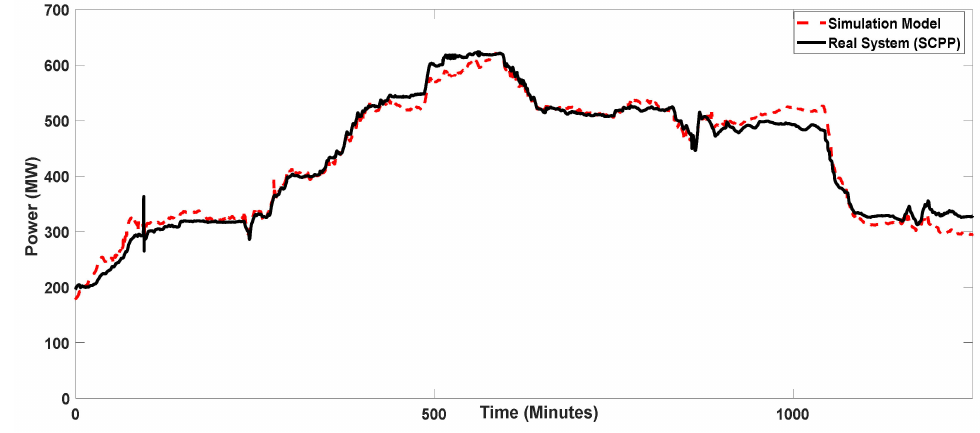
Figure 6. Measured and simulated SCPP output.